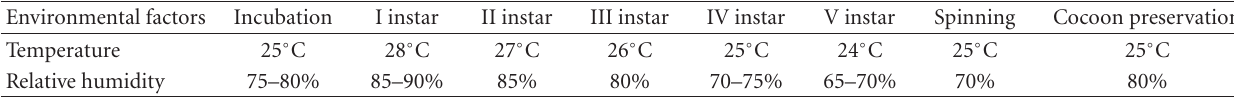
Table 1: Optimum temperature and humidity requirements of silkworm during various stages.